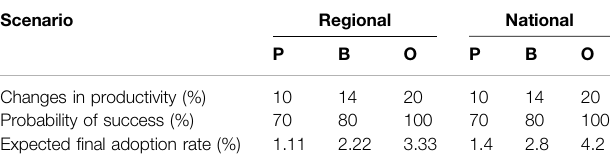
TABLE 4 | Scenarios for the sensitivity analysis of the economic surplus model for Brachiaria brizantha 26,124 cv. Agrosavia Caporal.